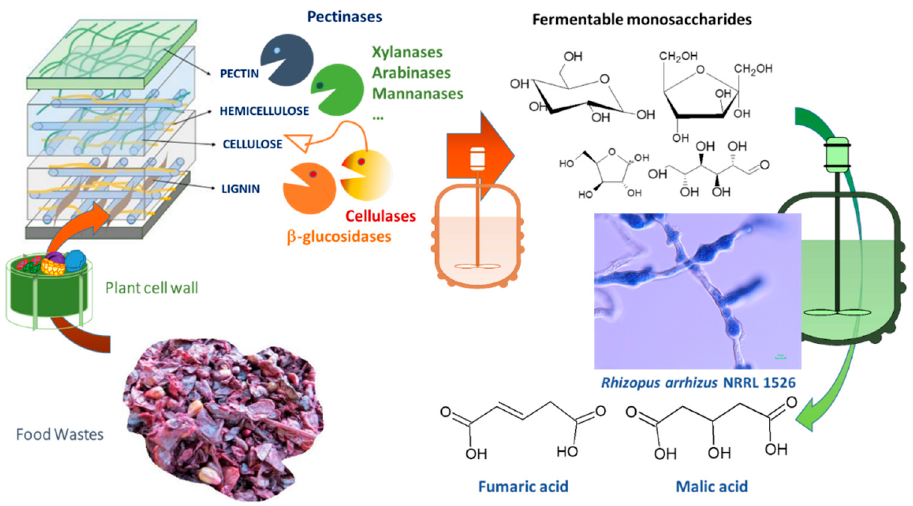
Figure 1. General process strategies from lignocellulosic biomass in food wastes to fumaric